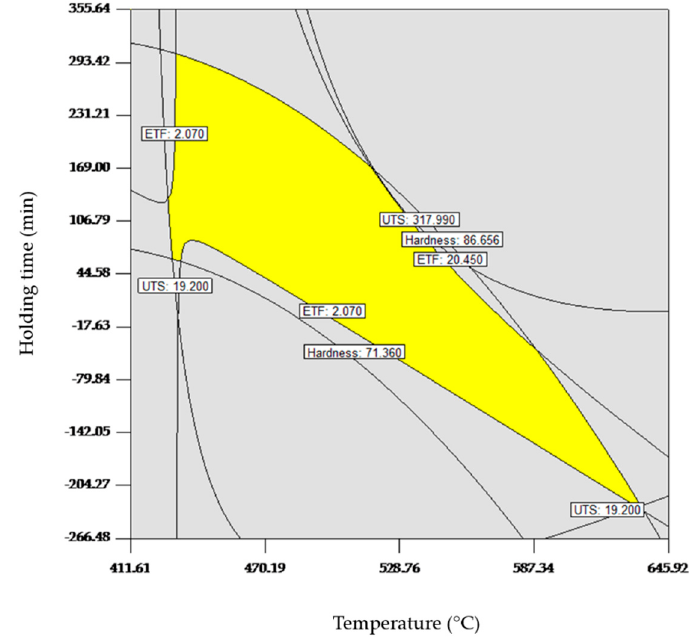
Figure 7. Overlay plot for optimization. Table 6. Suggested solution for optimum responses.